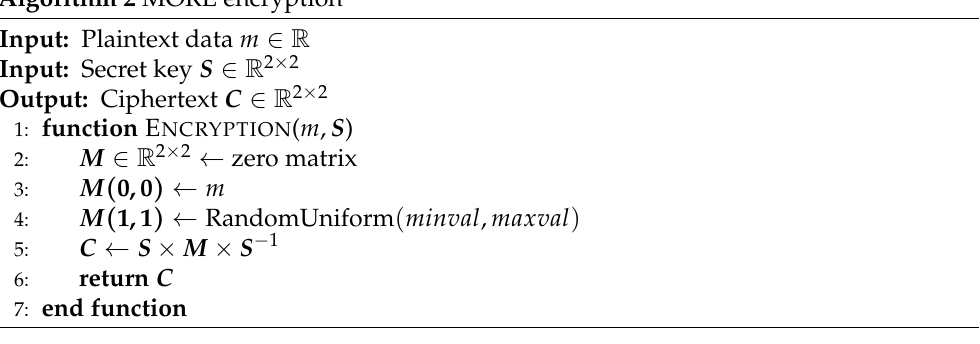
Algorithm 2 MORE encryption